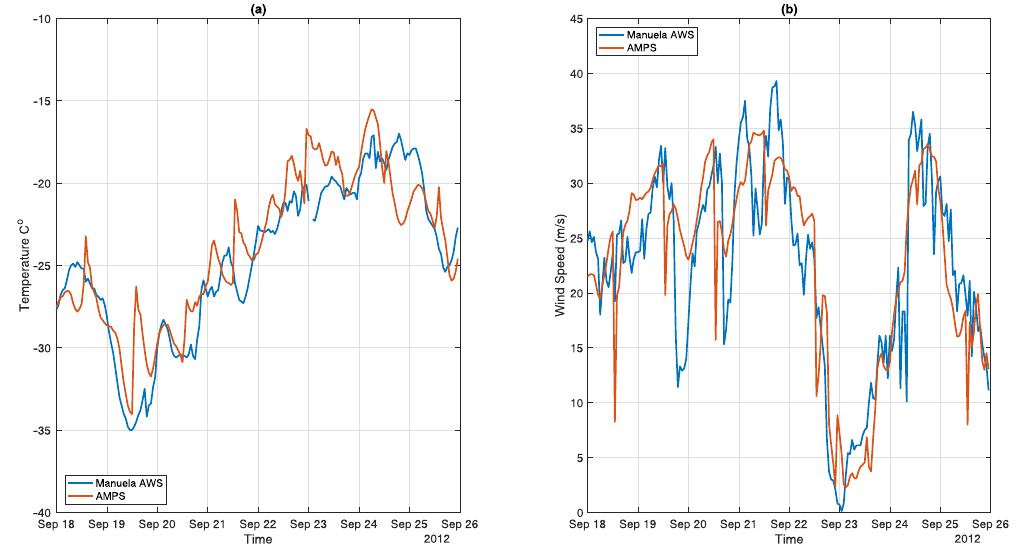
Figure 12. Observations from Manuela AWS station and model results from the nearest point to Manuela AWS location for ( a ) temperature and ( b ) wind speed between 18 and 25 September